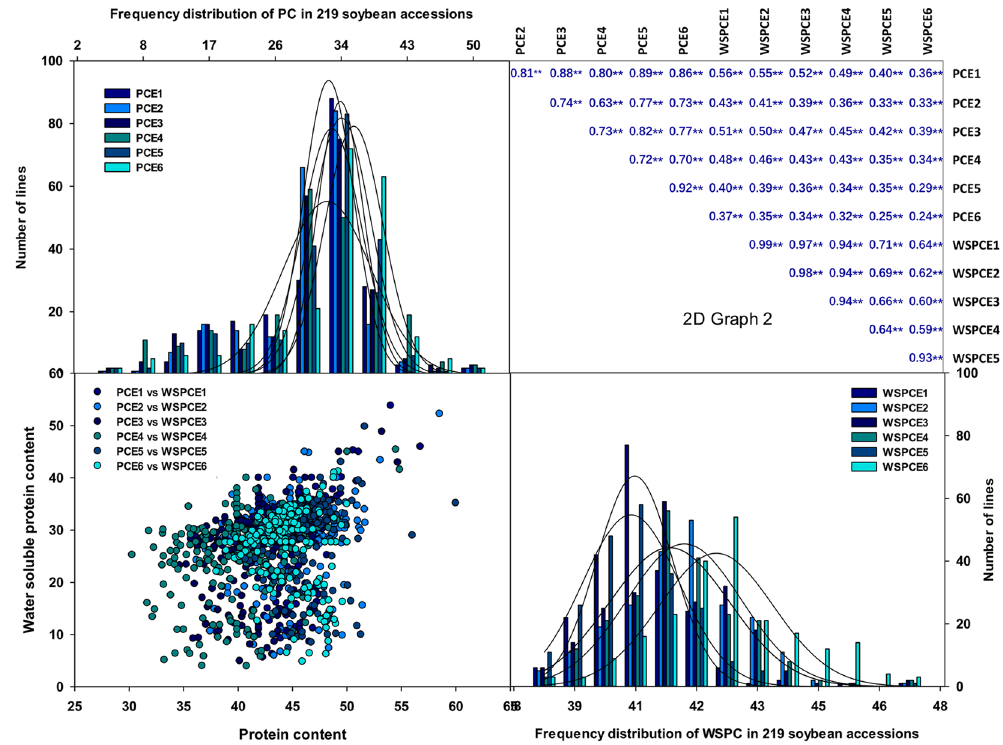
Figure 1. Phenotypic analysis of protein content (PC) and water-soluble protein content (WSPC) in the 219 soybean accessions. The histograms on the diagonal show the phenotypic distribution of each trait across six environments. The values above the diagonal are pairwise correlation coefficients between traits, and the plots below the diagonal are scatter plots of compared traits. PCE1-E6, denote the protein content in six different environments; WSPCE1-E6, denote the water-soluble protein content in the corresponding